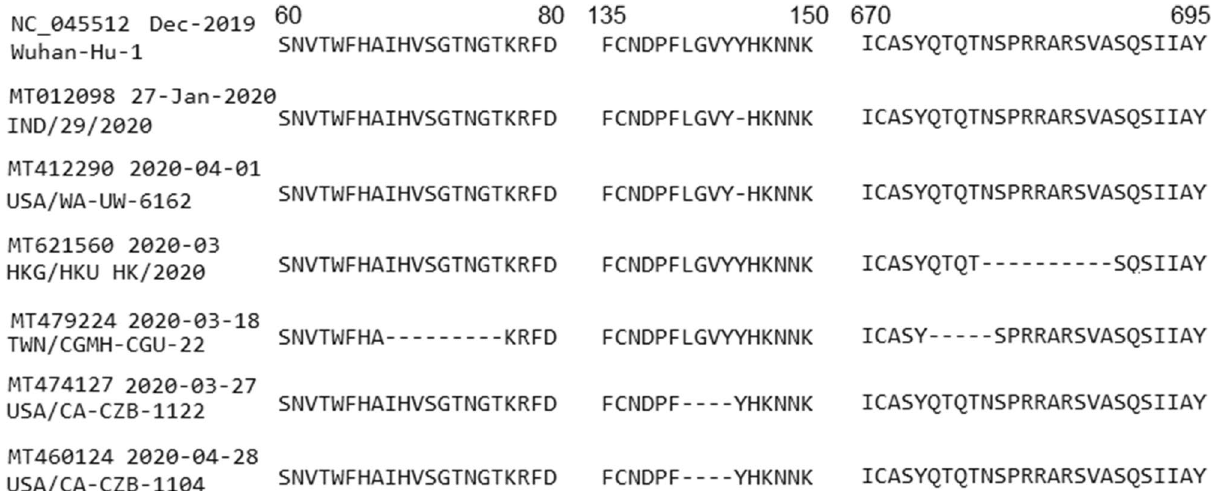
Figure 9. Deletions in protein S, which are all outside the RBD region (319–541), suggesting that the RBD may have been evolutionarily optimized for the purpose of binding to a host cell. The numbers on top show the residue positions in the protein. The GenBank accession numbers, collected dates and isolate names are presented on the left.